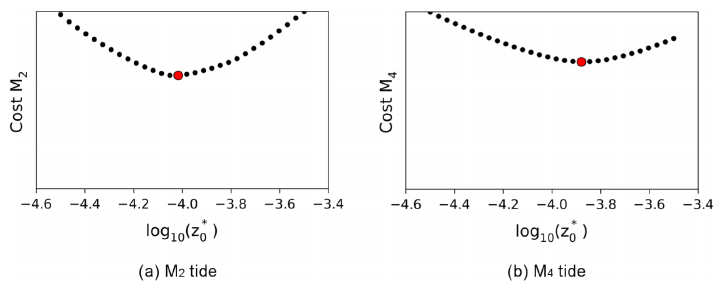
Figure 6. Cost function that measures the error between the measurements of the water level amplitude and model results for a range of values of the calibration parameter z ∗ . The error is plotted for the M 2 tide (a) and the M 4 tide (b) . The red dot marks the minimum error. 00 The absolute value of the error has no interpretation; therefore, no values are shown on the vertical